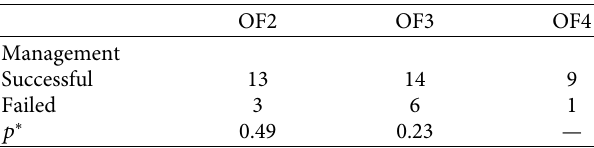
Table 4: Response to vertebral body augmentation by type of osteoporotic vertebral fracture.